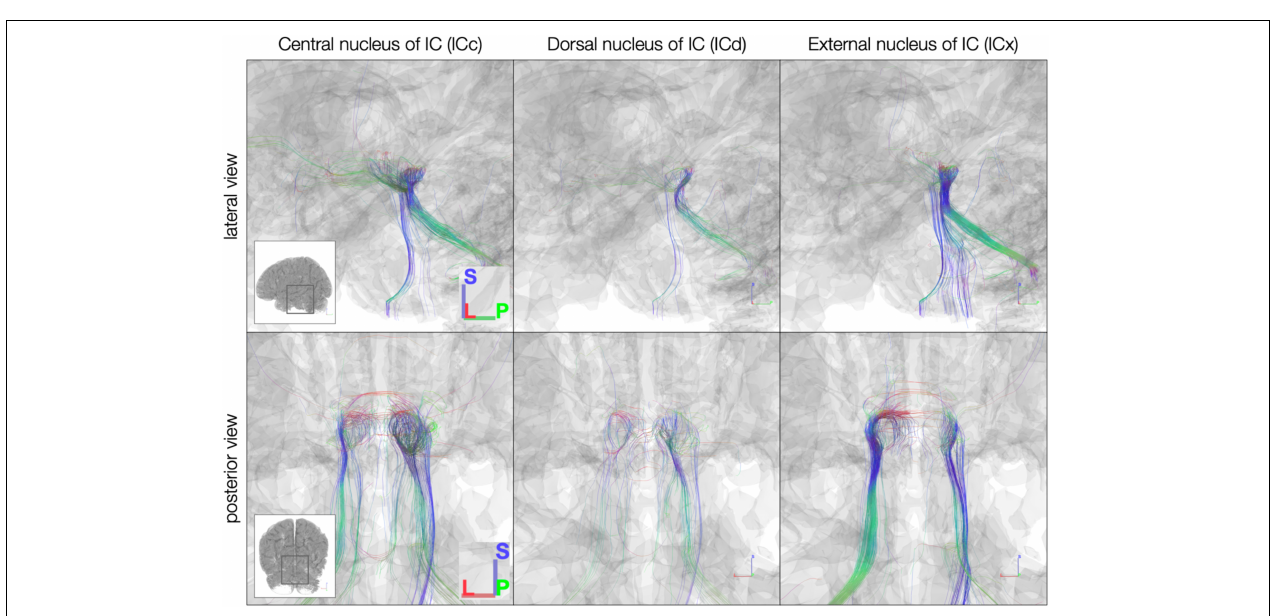
FIGURE 6 | Diffusion MRI tractography streamlines reaching each of the inferior colliculus subdivisions in the post mortem dataset. Colors represent local streamline orientation: blue, superior–inferior; red, left–right; green, anterior–posterior.